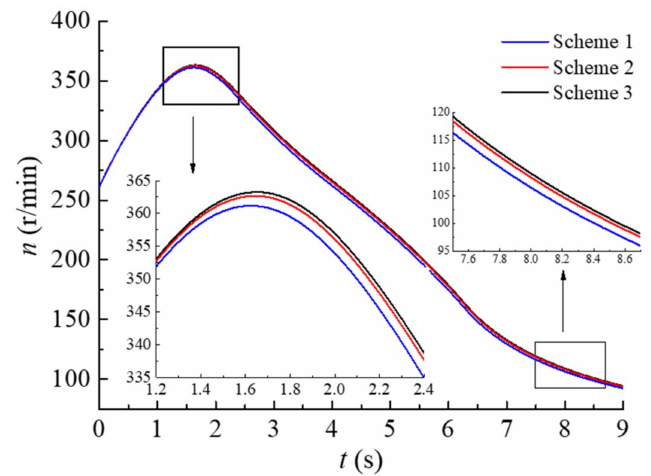
Figure 6. Test results of the three different mesh schemes.